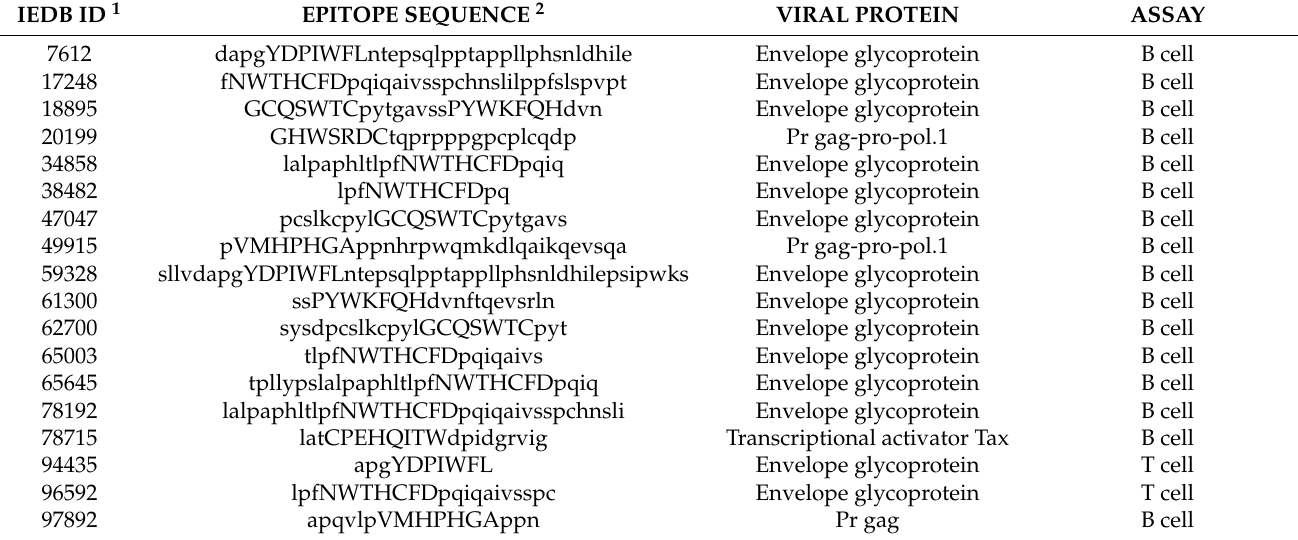
Table 2. Distribution among experimentally validated epitopes that are immunoreactive in the human host of peptides that are ≥ 7mer long, consist of overlapping minimal 5-mer immune determinants unique to HTLV-1, and are absent in the human proteome. 1 (www.iedb.org, accessed on 1 September 2020). 2 HTLV-1 peptides unique to HTLV-1 and absent in the human proteome are given in capital